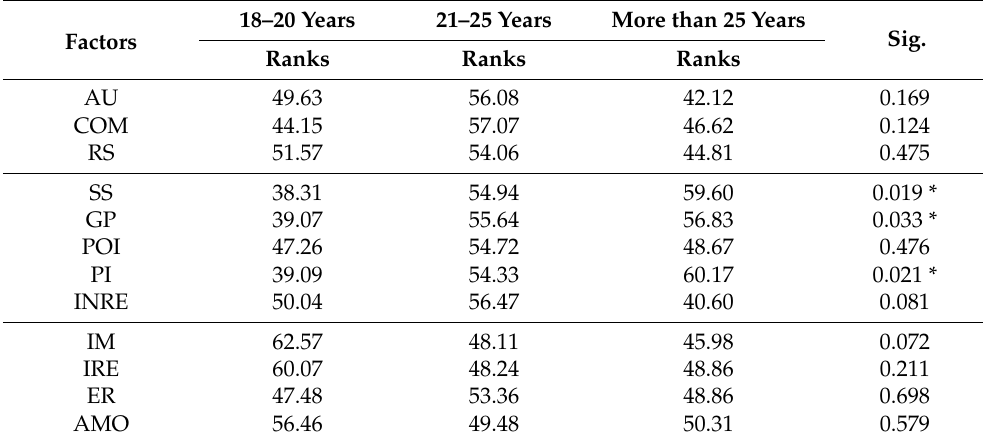
Table 5. Significant differences by age: Kruskal–Wallis